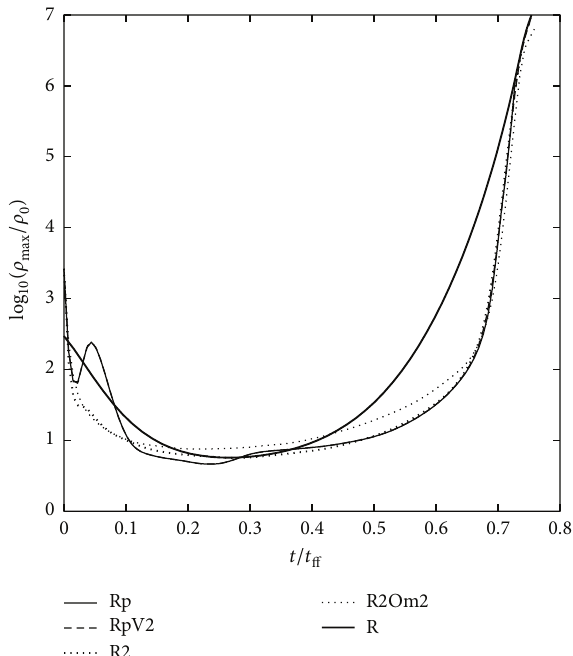
Figure 14: The peak density against the evolution time.